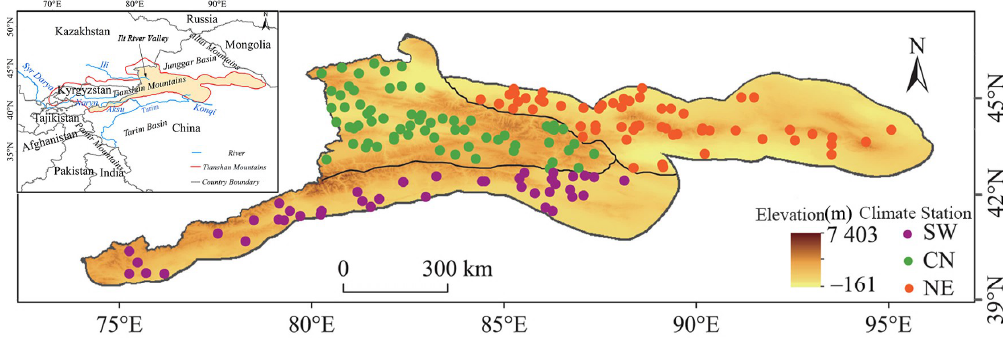
Figure 1. The study area and distribution of precipitation monitoring stations.